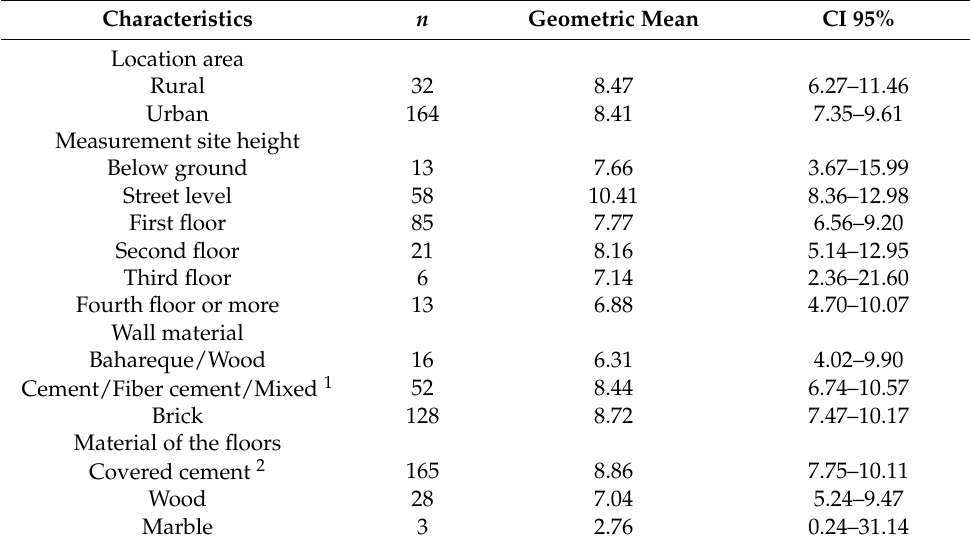
Table 1. 222 Rn concentrations in Manizales, according to dwelling